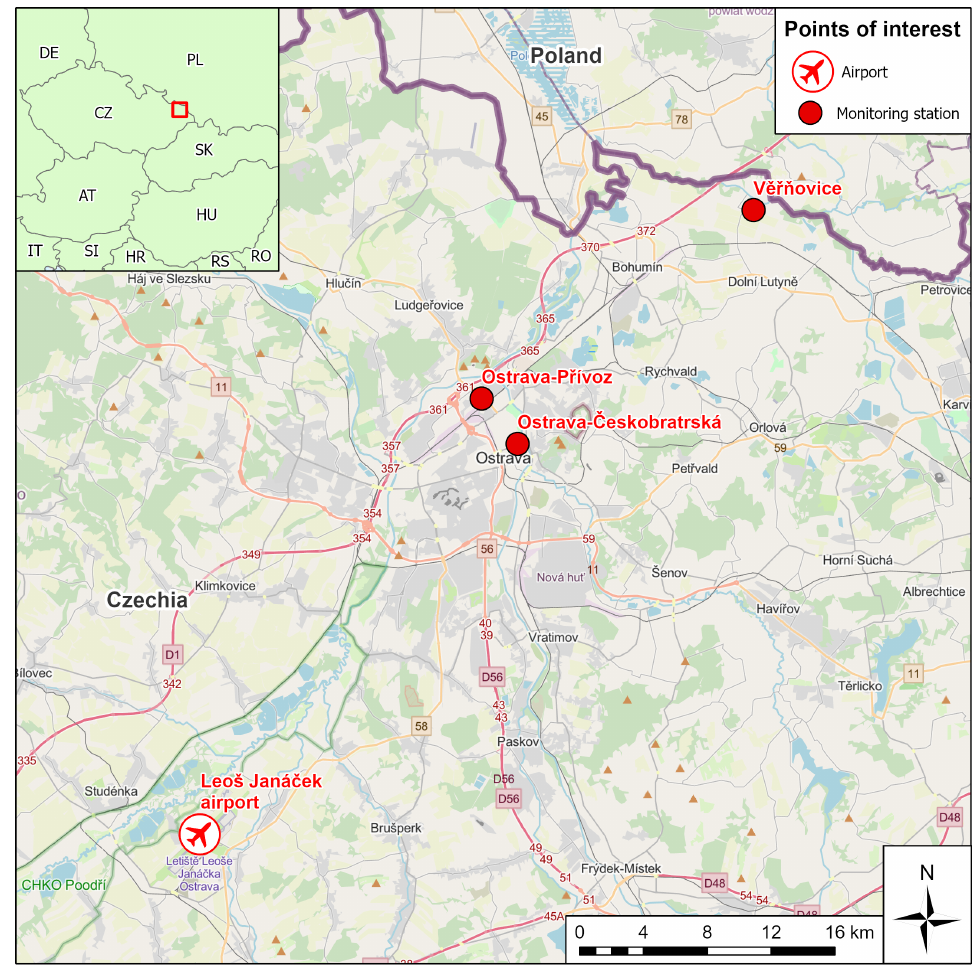
Figure 3. Location of pollution monitoring stations and the Ostrava